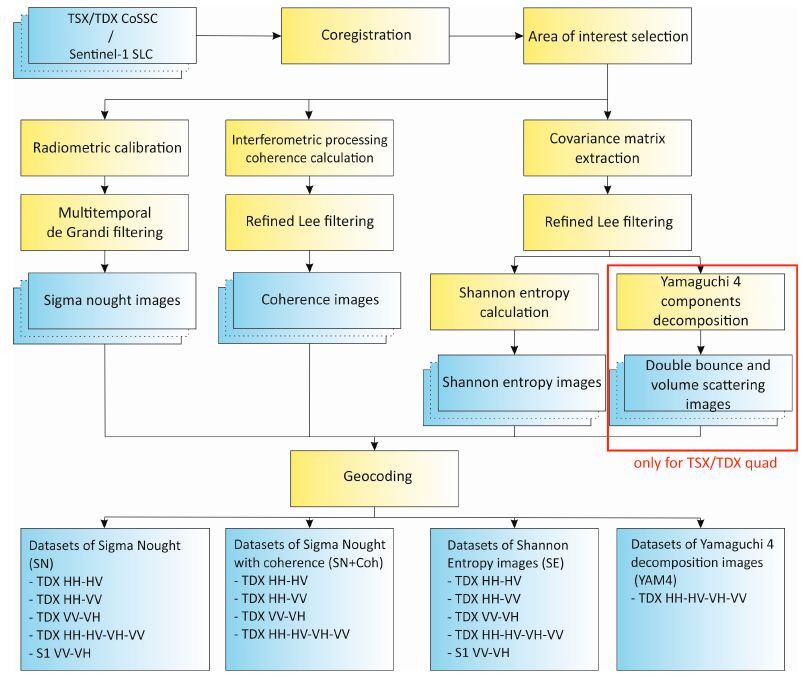
Figure 3. The workflow of image pre-processing.